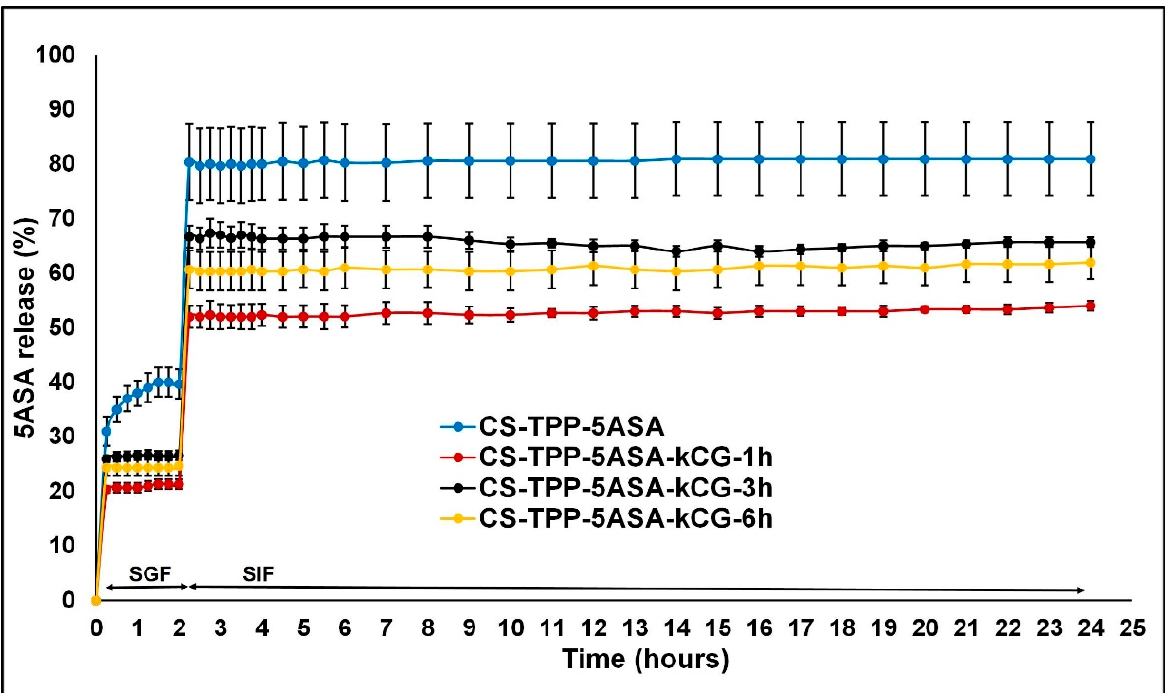
Figure 5. 5ASA release profiles from CS-TPP and CS-TPP-kCG under simulated conditions of drug passage through the gastrointestinal tract at 37 °C.